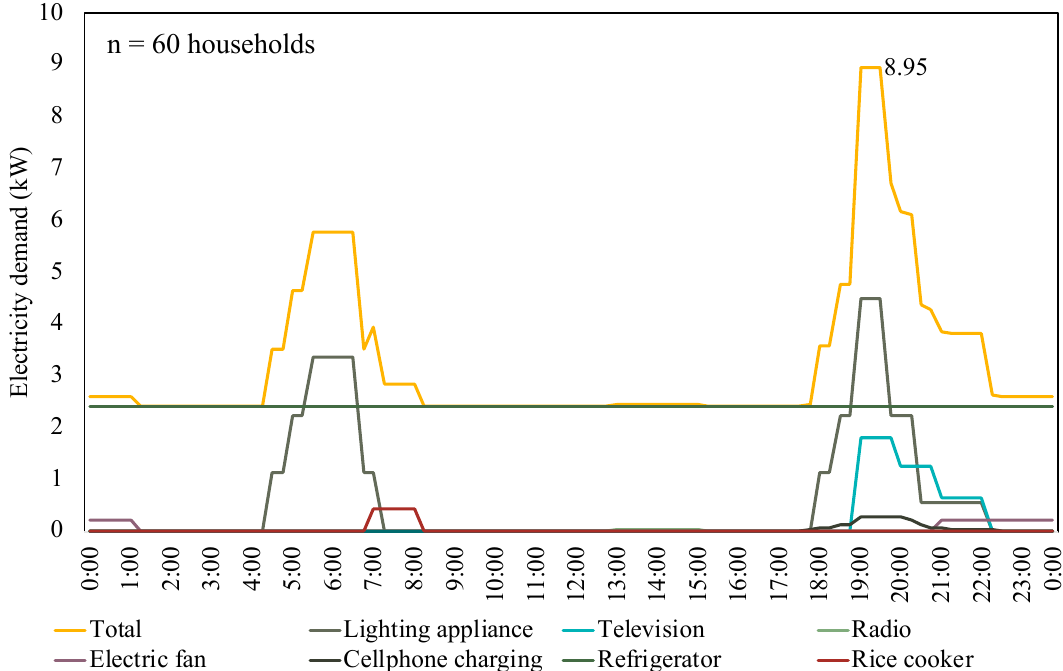
Figure 8. Current electricity demand daily load pattern of the Laos case study (during the warm season).